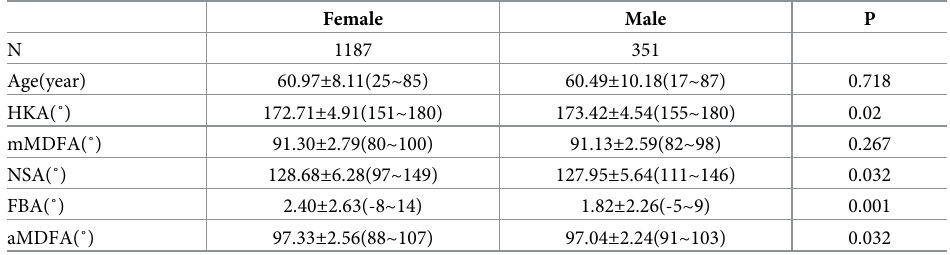
Table 2. Statistical description of